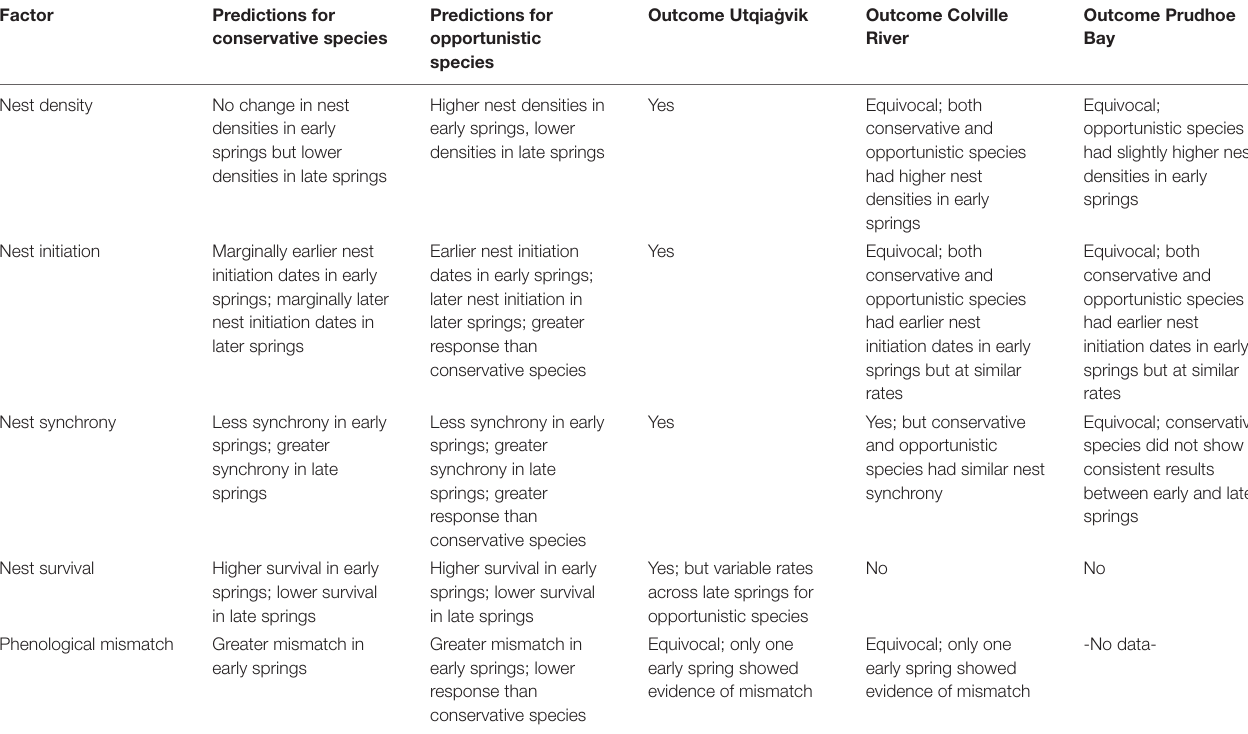
TABLE 1 | Predictions of how shorebirds would respond to early and late spring conditions by opportunistic and conservative reproductive strategies and the outcomes at Utqia˙gvik, Colville River, and Prudhoe Bay, 2015–2018.